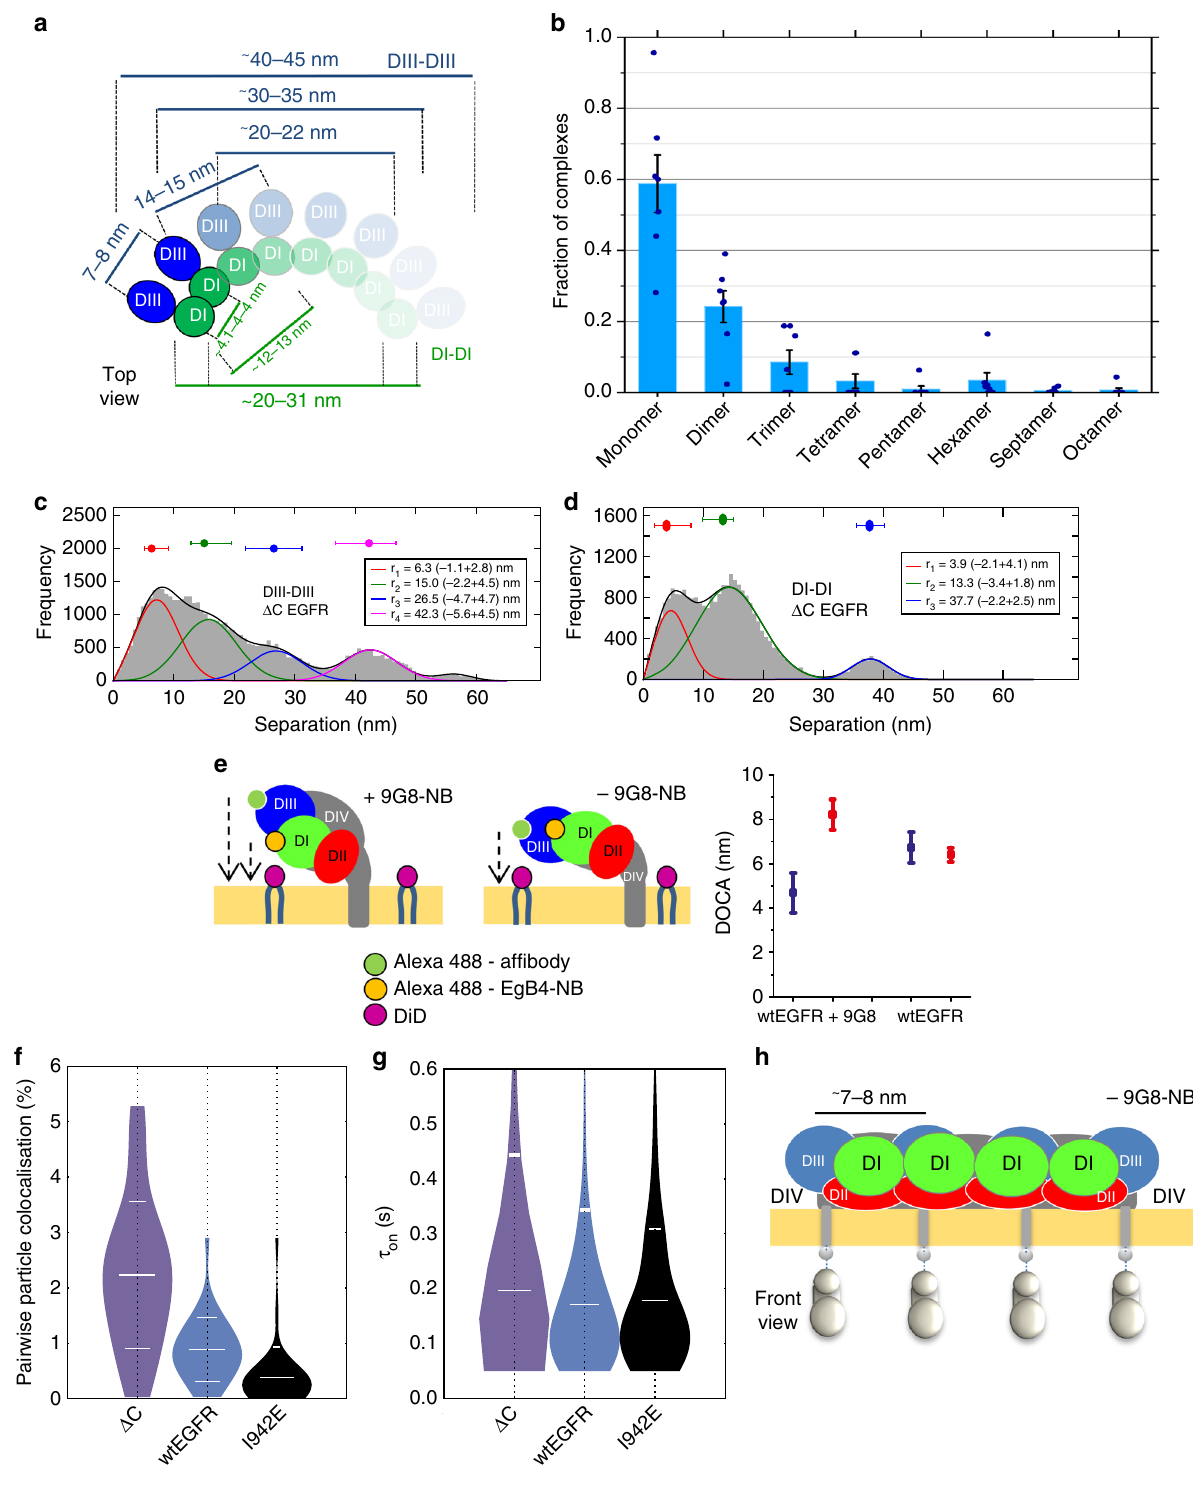
simulated head-to-head dimer model (no ICM), should form without inducing activation 42,46 (Supplementary Fig. 6). The polymers consistent with the model. To test this, we probed distribution of DI – DI separations is signi fi cantly compressed DIII – DIII separations on CHO cells that express Δ C-EGFR. The towards shorter values (Fig. 4d, Supplementary Figs. 8 and 9a – c). separations resolved are consistent with the head-to-head poly- Being smaller, fewer DI – DI separations are resolved, and those merisation model predictions (Fig. 4c, Supplementary Fig. 7). resolved are consistent with model predictions. The model also predicts shorter DI – DI separations (Fig. 4a, Predicted distances from DI and DIII to the membrane were green). We tested this using a CF640R derivative of an anti-EGFR tested by FRET 32 (Fig. 4e). In parallel experiments we labelled DI or DIII of wtEGFR with Alexa 488 derivatives of EgB4-NB or EgB4 nanobody (EgB4-NB) that speci fi cally binds DI of EGFR NATURE COMMUNICATIONS| (2018) 9:4325 |DOI: